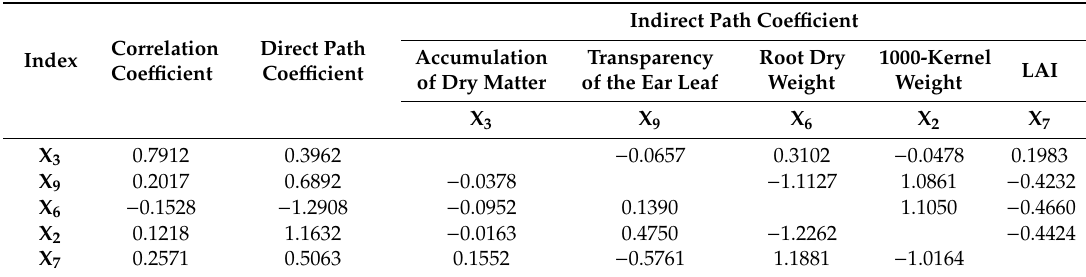
Table 6. Results of the path analysis of the indices and yield of high-yielding spring maize under